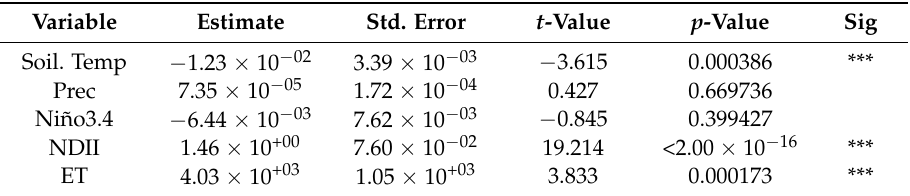
Table 1. The output of the Multiple Linear Regression (MLR) model in which Normalized Difference Vegetation Index (NDVI) is a dependent variable and soil temperature, precipitation (Soil Temp), Niño3.4, Normalized Difference Infrared Index (NDII), Dipole Model Index (DMI), and Evapotranspiration (ET) are independent variables.